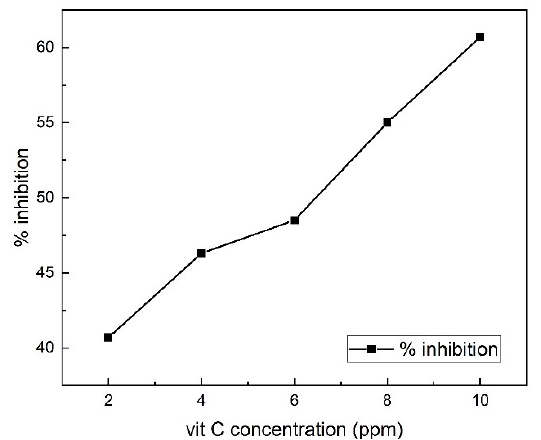
Fig. 7. Inhibition Percentage toward Vitamin C Concentration